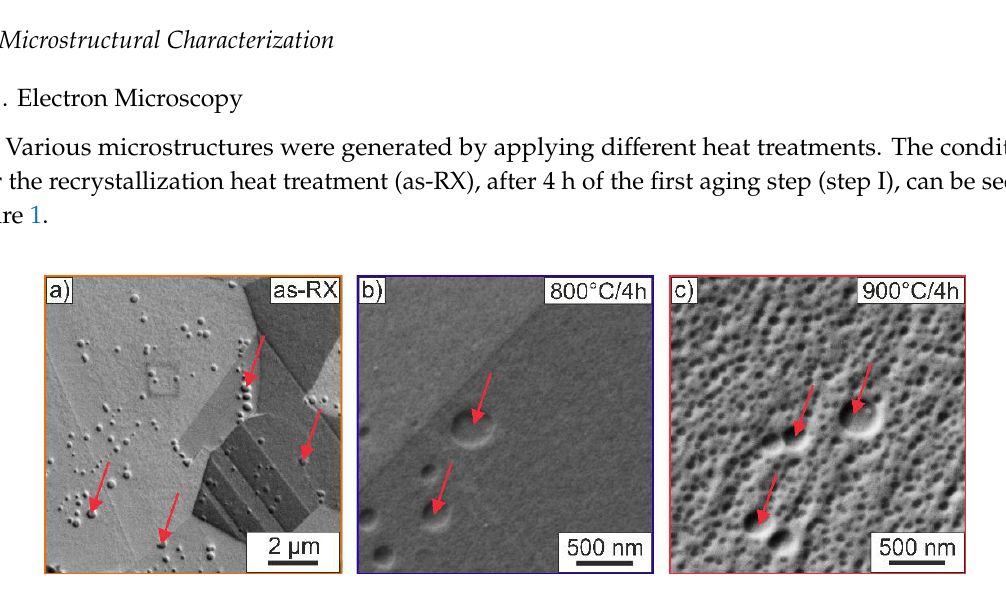
Figure 1. SEM images of different conditions: ( a ) as-RX; step I: ( b ) 800 °C/4 h and ( c ) 900 °C/4 h. The red arrows indicate the primary precipitates.